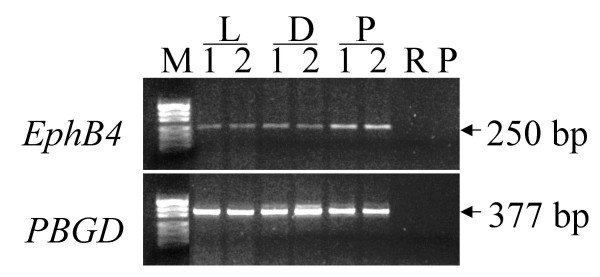
RT-PCR analysis of EphB4 expression in prostate cancer cell lines. RT-PCR analysis of EphB4 and PBGD expression in duplicate RNA samples from the three prostate cancer cell lines LNCaP, DU145 and PC3. Sizes of the amplified products are shown on the right (bp). An RNA sample to which no reverse transcriptase was added and a PCR reagent only (containing no template) amplification were also performed as negative controls for each stage of the RT-PCR.